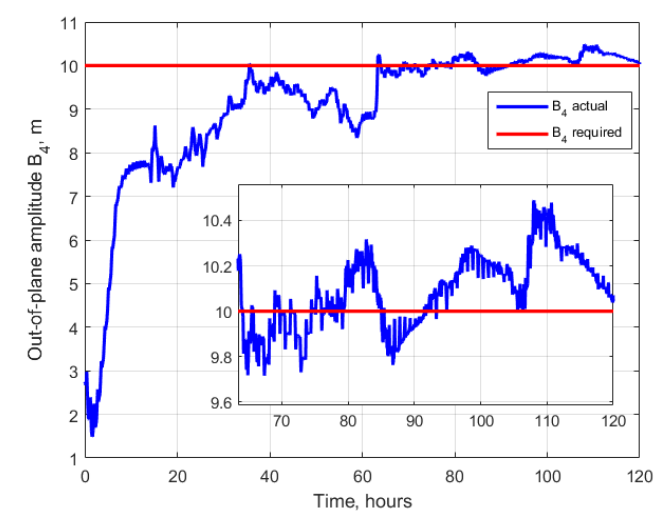
Figure 8. Out-of-plane amplitude.